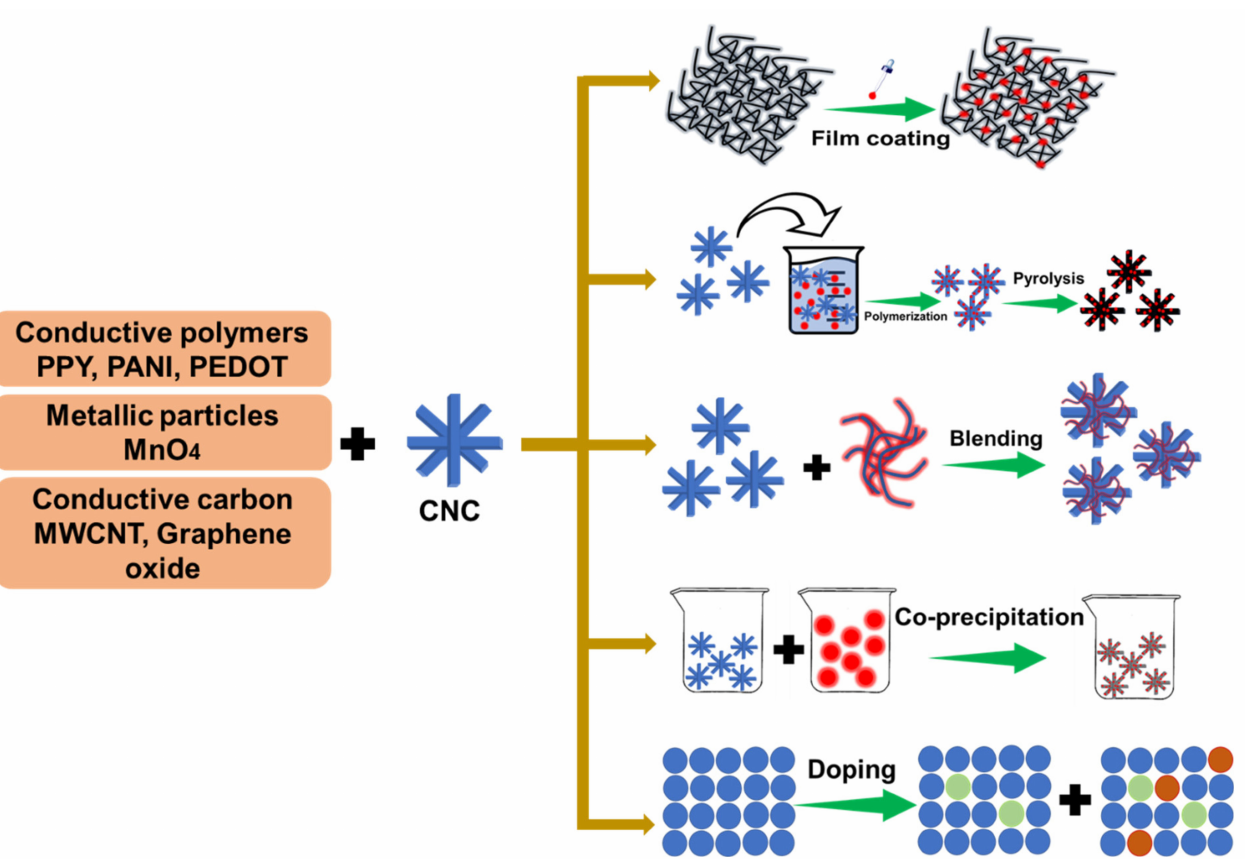
Figure 6. Various methodologies to develop novel conductive cellulose nanocrystals